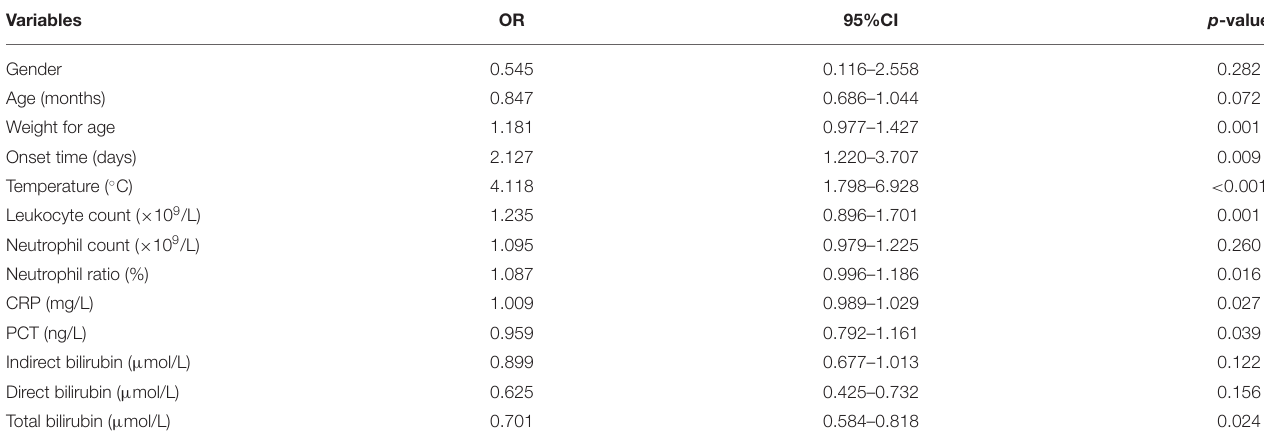
TABLE 2 | Univariate logistic regression analysis of various risk factors.